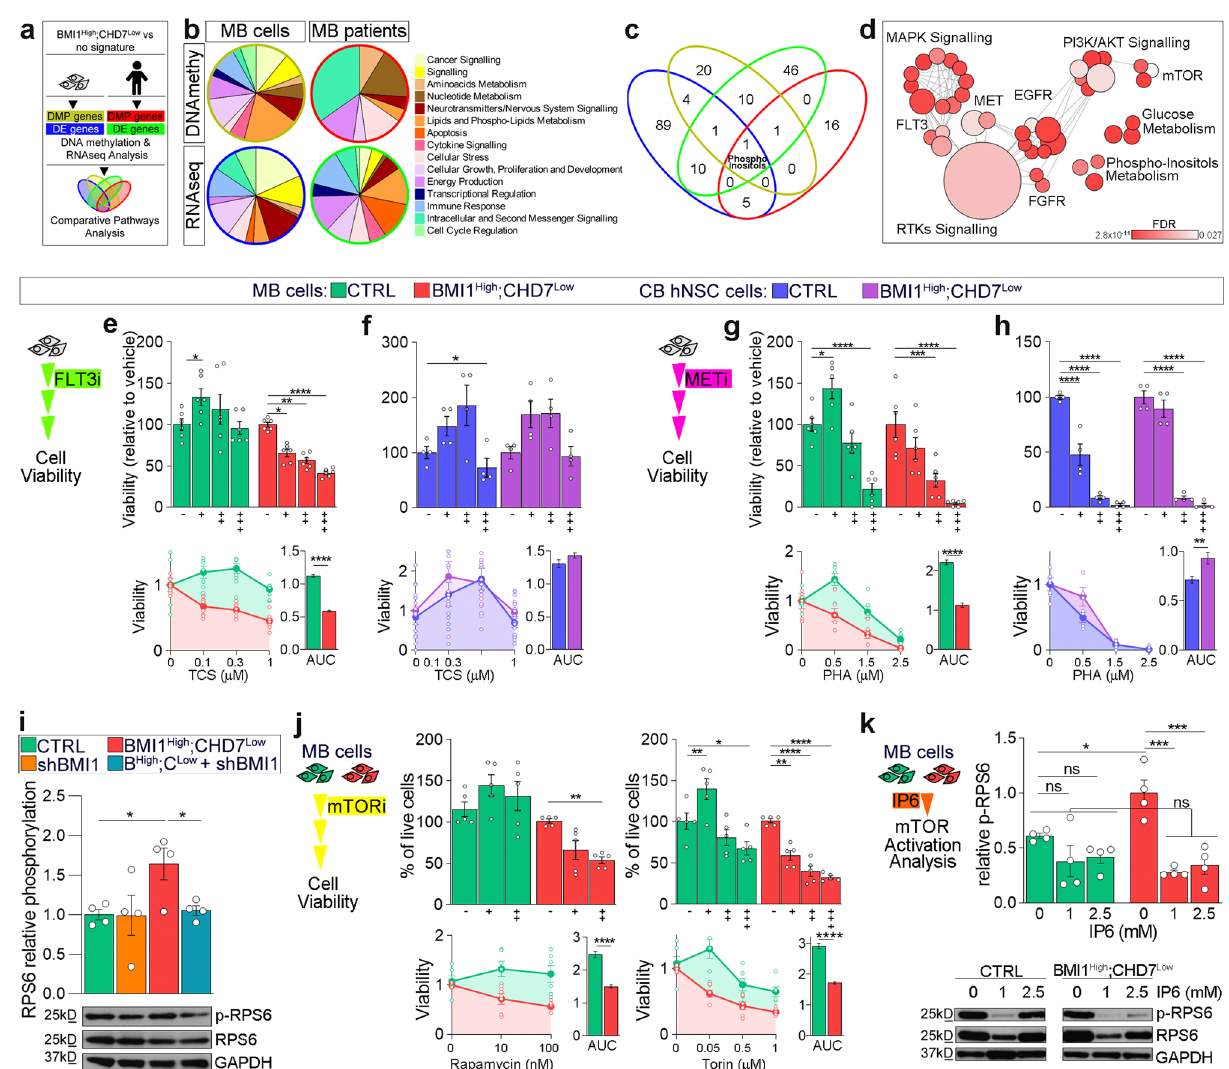
Fig. 2 Phosphoinositol metabolism is deregulated in BMI1 High ;CHD7 Low G4 MB and activation of the mTOR pathway is observed speci fi cally in MB cells modelling this subgroup. a Schematic representation of the comparative analysis between BMI1 High ;CHD7 Low MB cell lines and G4 patients with and without the signature performed to identify genes differentially expressed (DE) and differentially methylated probes (DMP) and commonly deregulated pathways. b Pie charts representing canonical pathways differentially enriched between MB cells or patients with or without BMI1 High ;CHD7 Low signature identi fi ed in RNA-Seq or DNA methylation analysis. Canonical pathways are classi fi ed based on IPA categories list and colour-coded accordingly. c Venn diagram of canonical pathways enriched for genes differentially expressed (blue and light-green diagrams as coloured in a and b ) or methylated (olive green and red as coloured in a and b ) in BMI1 High ;CHD7 Low cell lines and GR4 MBs with the matching signature. Highlighted the superpathway of phosphoinositol compounds (phosphoinositols), which is common to all the datasets analysed. d Bubble plot showing signi fi cant Reactome pathways obtained in phosphoproteomic analysis of BMI1 High ;CHD7 Low MB lines. Bubbles are coloured based on FDR values, and size is proportional to the number of genes of speci fi c pathways. e , f Cell viability assays of MB cells ( e ) or hNSC ( f ) with (BMI1 High ;CHD7 Low ) or without the signature (CTRL) upon 72 h of treatment with increasing concentrations of FLT3 inhibitor (TCS). Histograms represent the percentages of viable cells relative to non-treated cells (top). Measurement of Area Under Curve (AUC) (bottom) to compare the overall response to treatment. e n = 6 biologically independent experiments, ( f ) n = 4 biologically independent experiments, two-way ANOVA. g , h Cell viability assays of MB cells ( g ) or hNSC ( h ) with (BMI1 High ;CHD7 Low ) or without the signature (CTRL) upon 72 h of treatment with increasing concentrations of MET inhibitor (PHA). Histograms represent the percentages of viable cells relative to non-treated cells (top). Measurement of the area under the curve (AUC) (bottom) to compare the overall response to treatment. g n = 6 biologically independent experiments, h n = 4 biologically independent experiments, two-way ANOVA. i Western blot and quanti fi cation of phosphorylated/total RPS6 (pRPS6, Ser240/244) in MB cells. GAPDH immunoreactivity was used to normalise protein loading. n = 4 biologically independent experiments, one-way ANOVA. j Cell viability assays of MB cells with (BMI1 High ;CHD7 Low , red) or without the signature (CTRL, green) upon 72 h of treatment with increasing concentrations of mTOR pathway inhibitors (rapamycin and torin). Histograms represent the percentages of viable cells relative to non-treated cells (top). Measurement of Area Under Curve (AUC) (bottom) to compare the overall response to treatment. n = 5 biologically independent experiments, two-way ANOVA. k Western blot and quanti fi cation of phosphorylated/total RPS6 (pRPS6, Ser240/244) after 24 h of treatment with increasing concentrations of IP6 in control (green) or BMI1 High ;CHD7 Low (red) MB cells. GAPDH immunoreactivity was used to normalise protein loading. n = 4 biologically independent experiments, two-way ANOVA. All graphs report mean ± SEM. P values: * P < 0.05, ** P < 0.01, *** P < 0.001 or **** P < 0.0001. Source data are provided as a Source Data fi